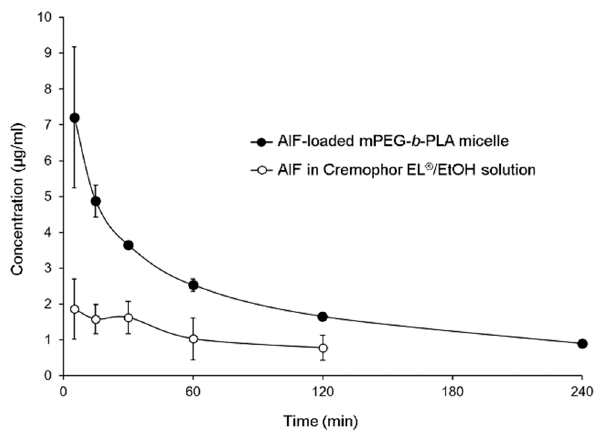
Figure 6. Alpinumisoflavone (AIF) plasma concentration time profile after intravenous (i.v.) administration of AIF-loaded mPEG- b -PLA micelles and AIF dissolved in 25% Cremophor EL ® /ethanol (EtOH) solution. Table 3. Pharmacokinetic parameters of alpinumisoflavone (AIF) after intravenous (i.v.) injection of AIF-loaded mPEG- b -PLA micelles and AIF dissolved in 25% Cremophor EL ® /ethanol (EtOH) solution.